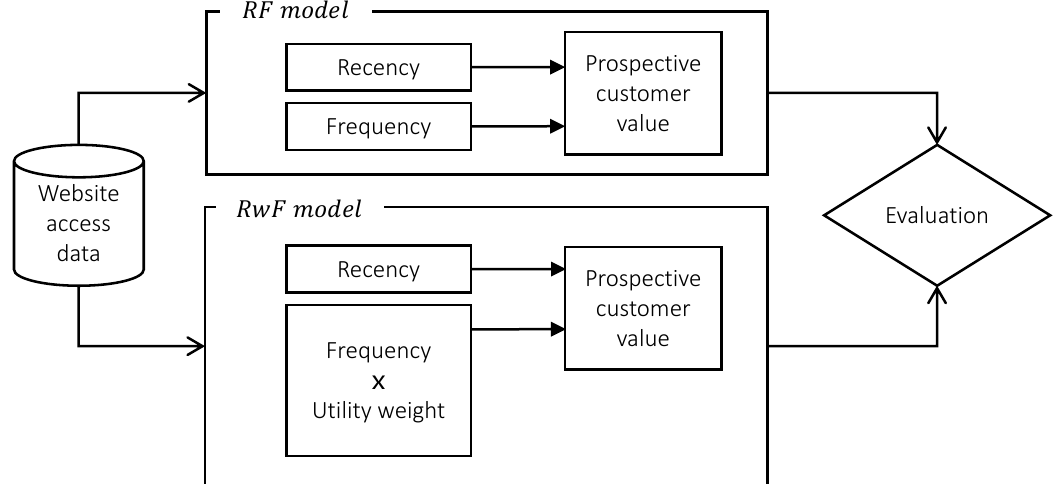
Figure 1. Conceptual framework to identify prospective